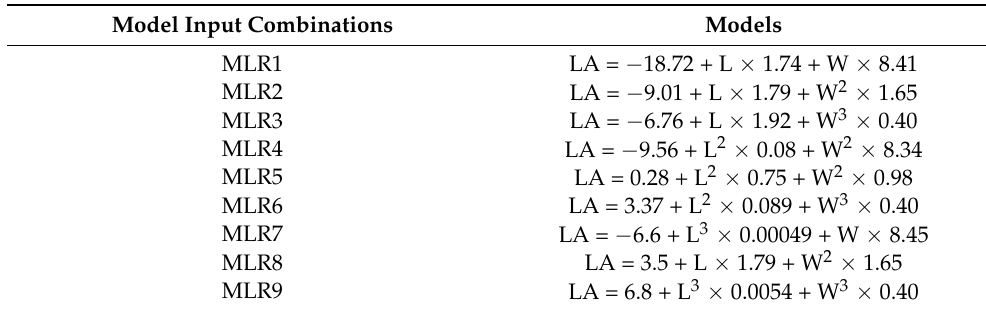
Table 7. Developed LA models for three orders of L and W input combinations of D. nobile leaves using MLR